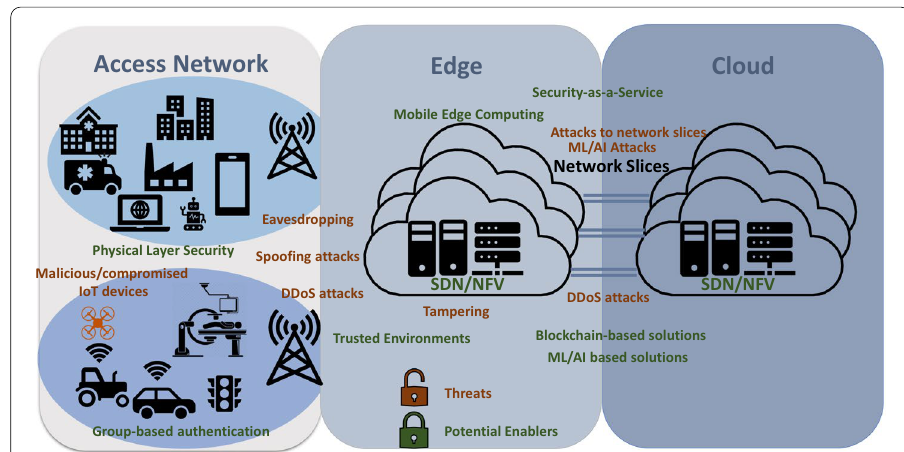
Fig. 7 6G security solution landscape. Security landscape for 6G MTC